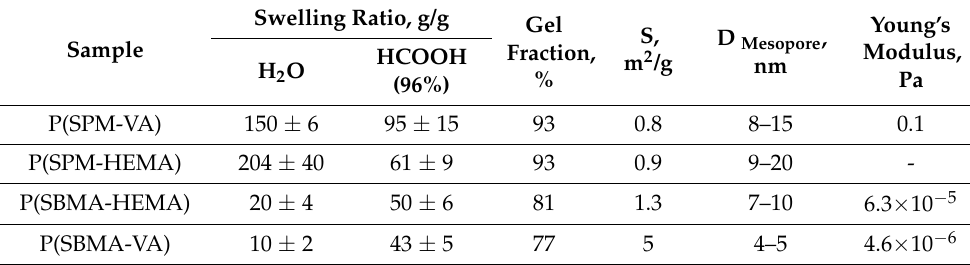
Table 2. Characteristics of cryogels based on SPM and